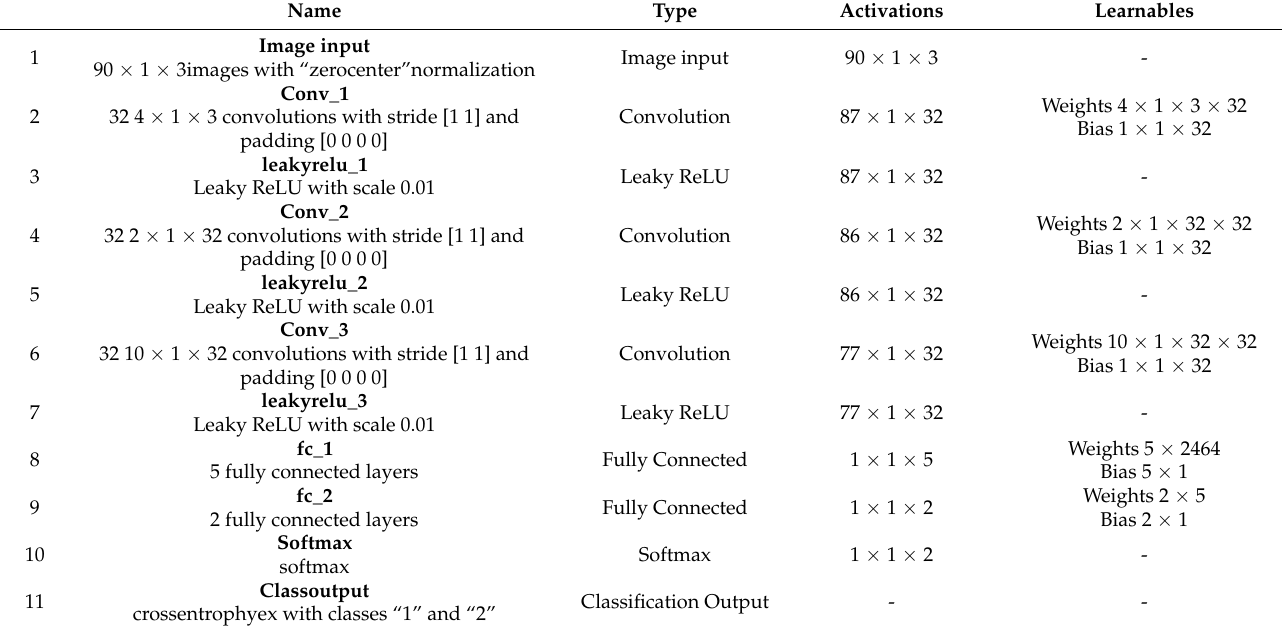
Figure 4. Graphical illustration of the proposed CNN architecture. The network consists of 3 convolution and 2 fully connected layers. Table 1. Elements of the proposed CNN